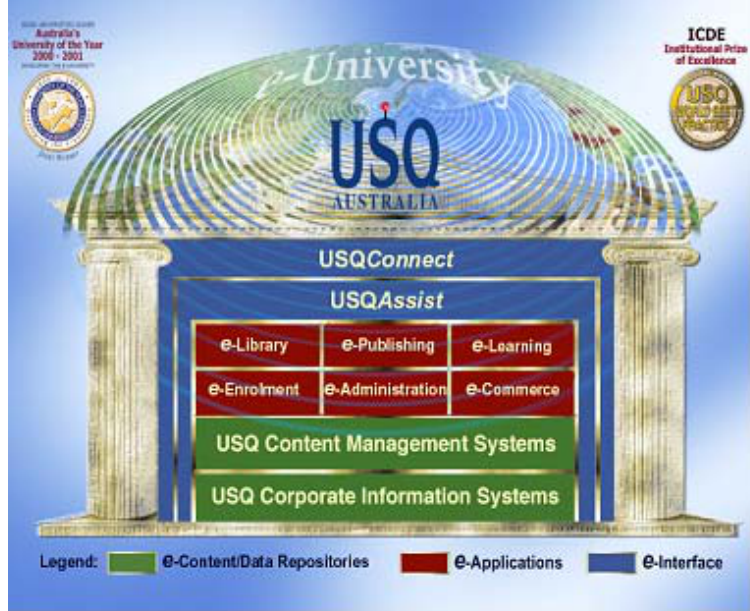
Figure 1. USQ e-University Project